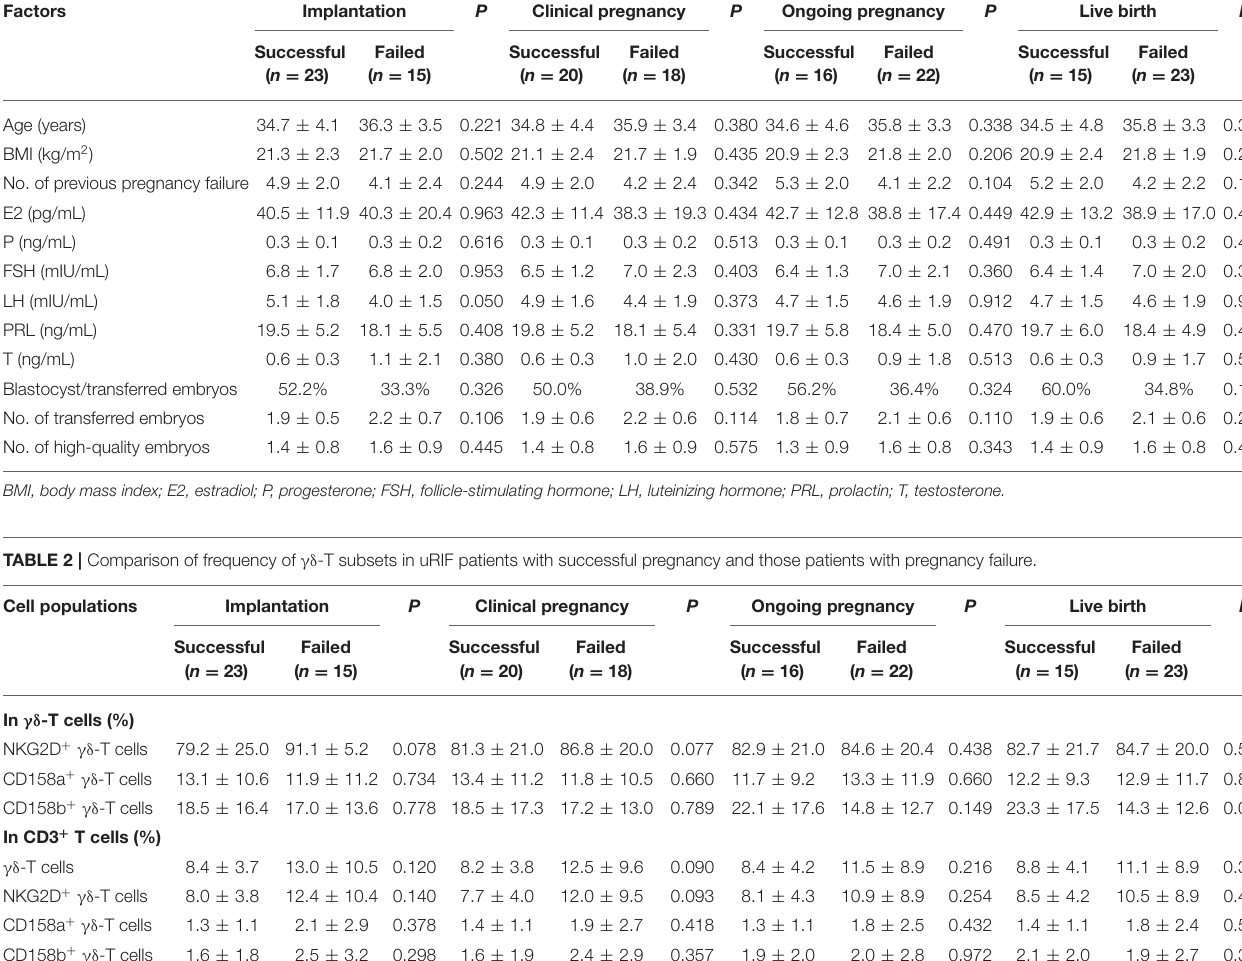
TABLE 1 | Clinical characteristics of uRIF patients categorized according to the pregnancy outcome. Factors Implantation P Clinical pregnancy P Ongoing pregnancy P Live birth P